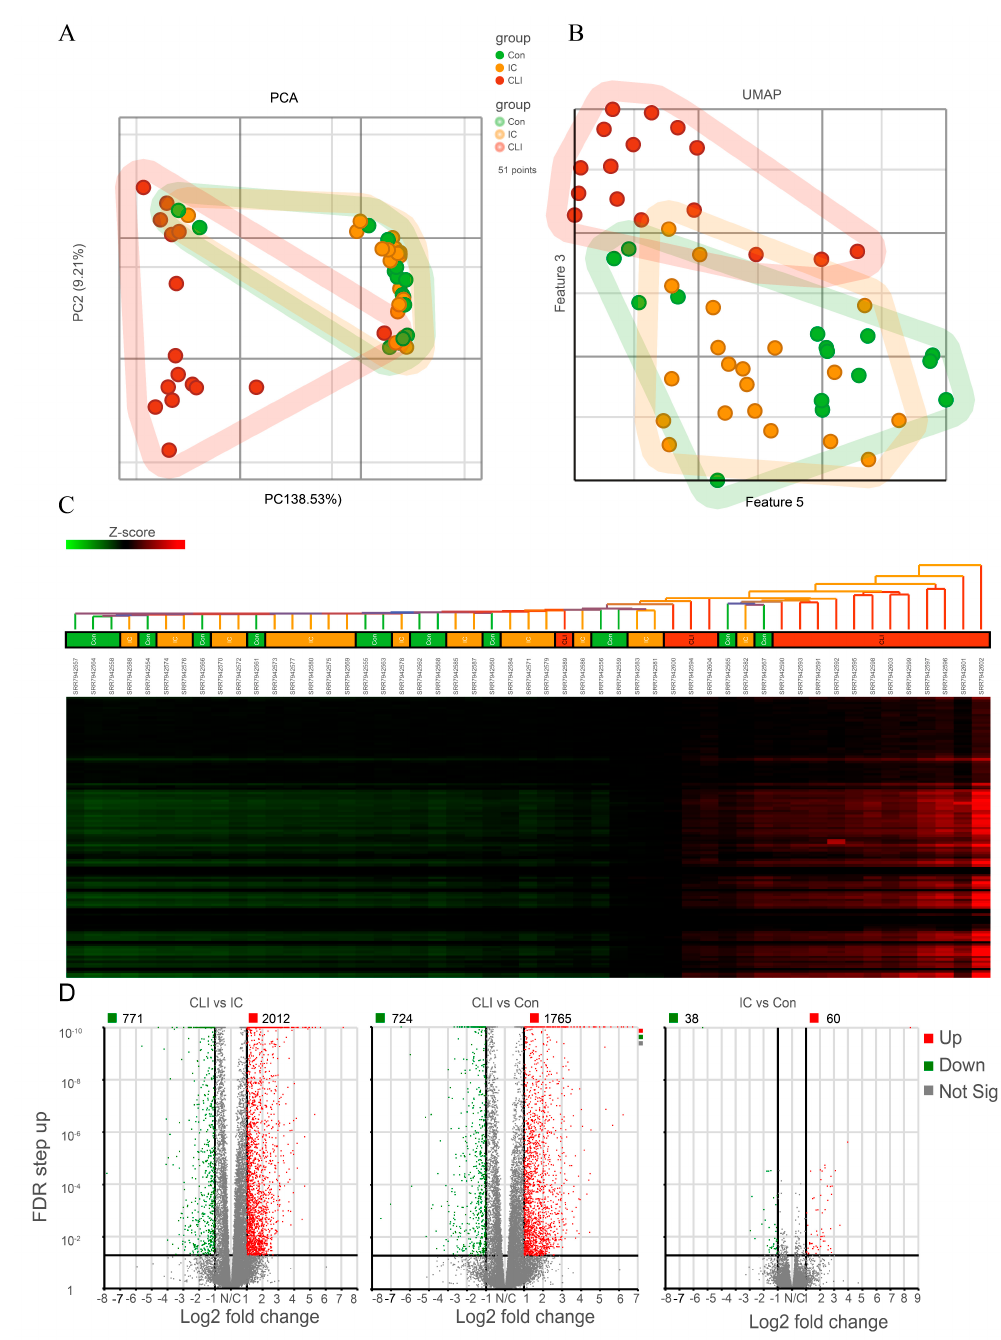
Figure 2. Unique gene expression profile presenting in CLI patients. ( A ) Principal component analysis (PCA) of the samples. Each dot represents one subject. ( B ) (UMAP) of the samples. Each dot represents one subject. ( C ) Heatmap of all di ff erentially expressed genes among groups. Samples are on columns, genes are on columns, and the heat map is based on standardized gene expression values. ( D ) Volcano plot representing di ff erential gene expression among groups. Each dot on the plot is a single gene. Horizontal axis: fold change; vertical axis: false discovery rate (FDR) p -value (in log10 scale) by Wald test. Color coding is based on the fold change. Thick vertical lines highlight fold changes of − 2 and + 2, while a thick horizontal line represents a FDR p -value of 0.05. N = 15 for non-PAD controls, N = 20 for IC, N = 16 for CLI. PC1, principal component; CLI, critical limb ischemia; IC, intermittent